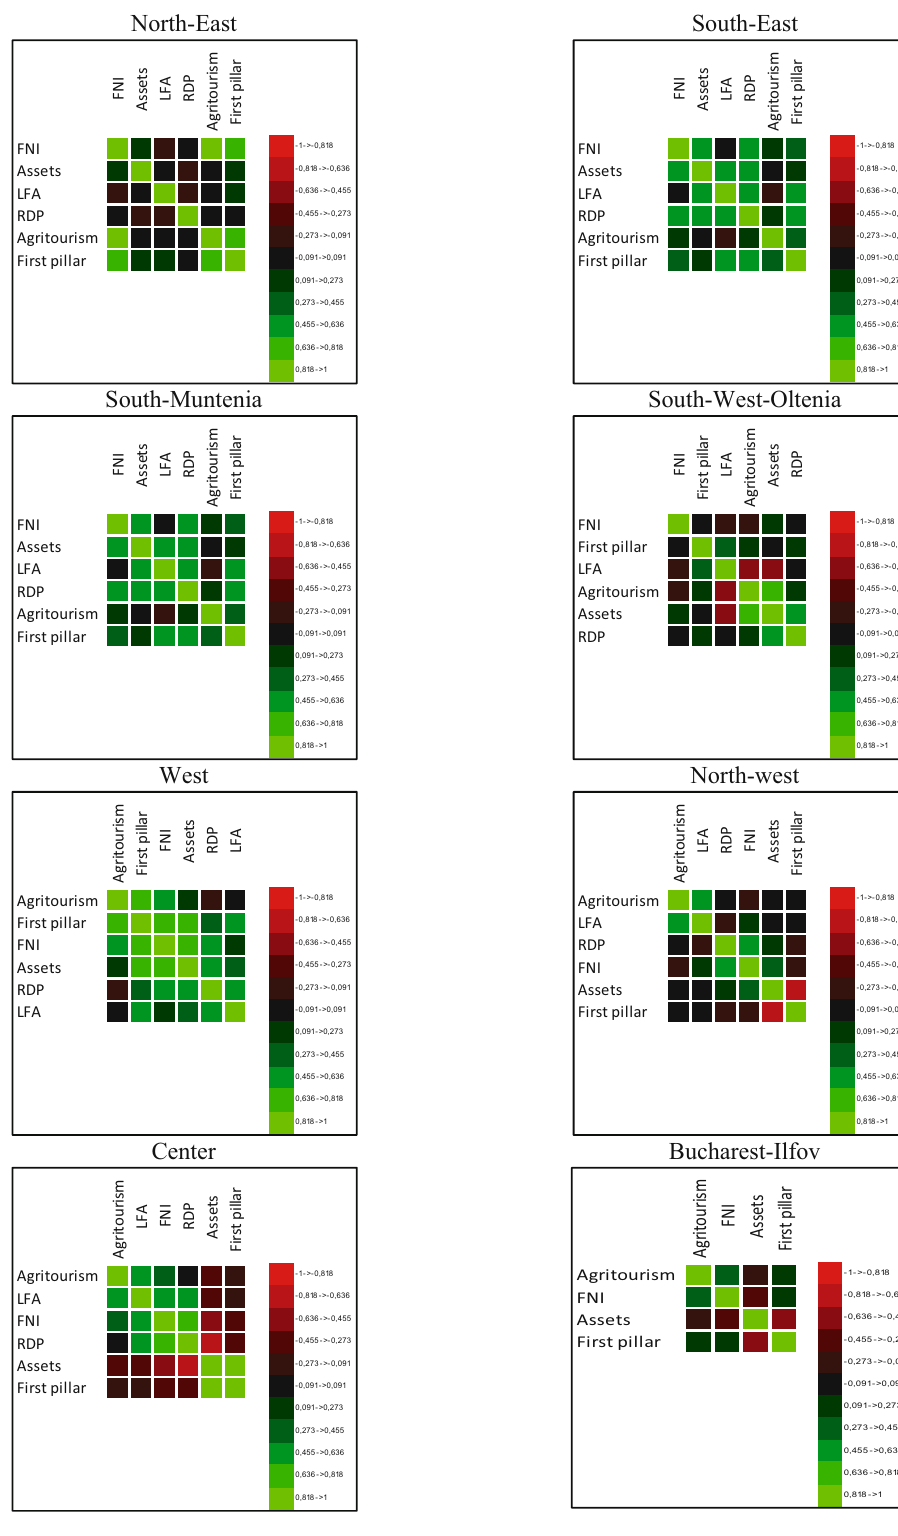
Figure 6: Main correlations in all investigated variables in di ff erent Romanian regions ( source: author ’ s own elaboration on data available at http://statistici.insse.ro and https://ec.europa.eu/agriculture/rica/database/database_en.cfm )